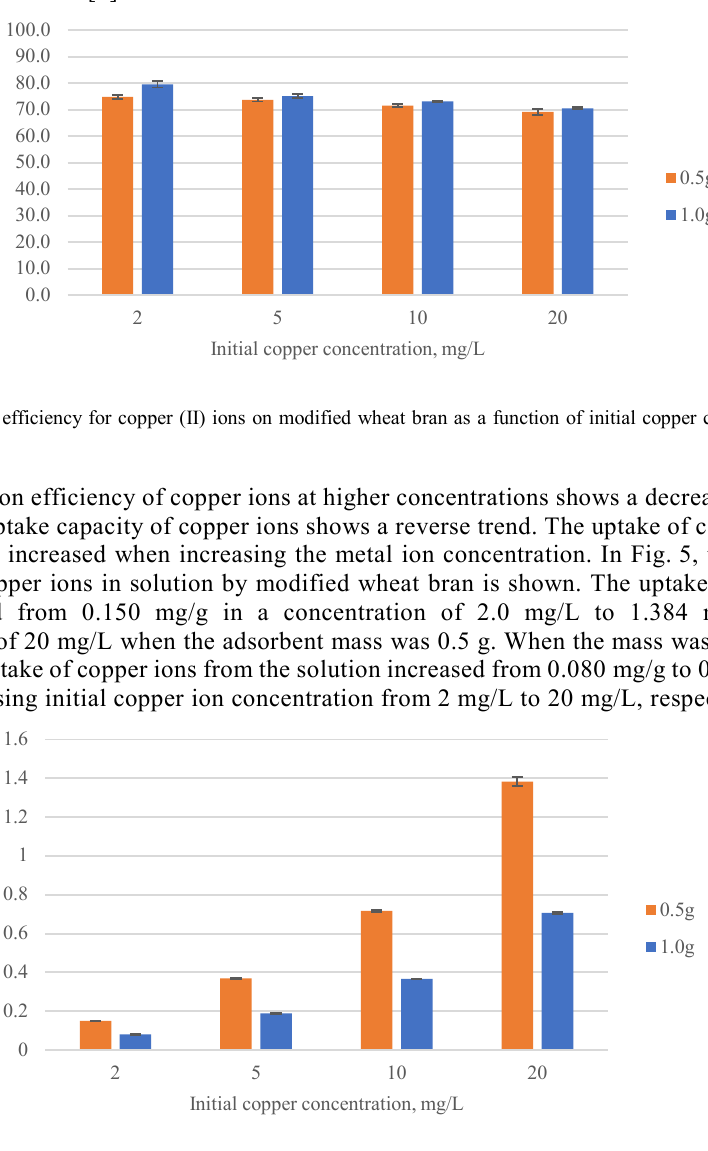
Fig. 5. Influence of initial Cu (II) ions’ concentration on adsorption capacity on modified wheat bran, n = 3,